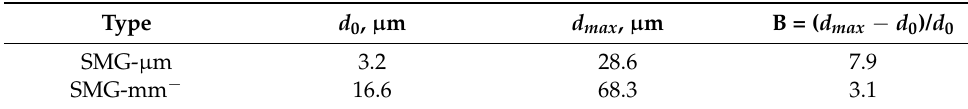
Table 1. Swelling property of